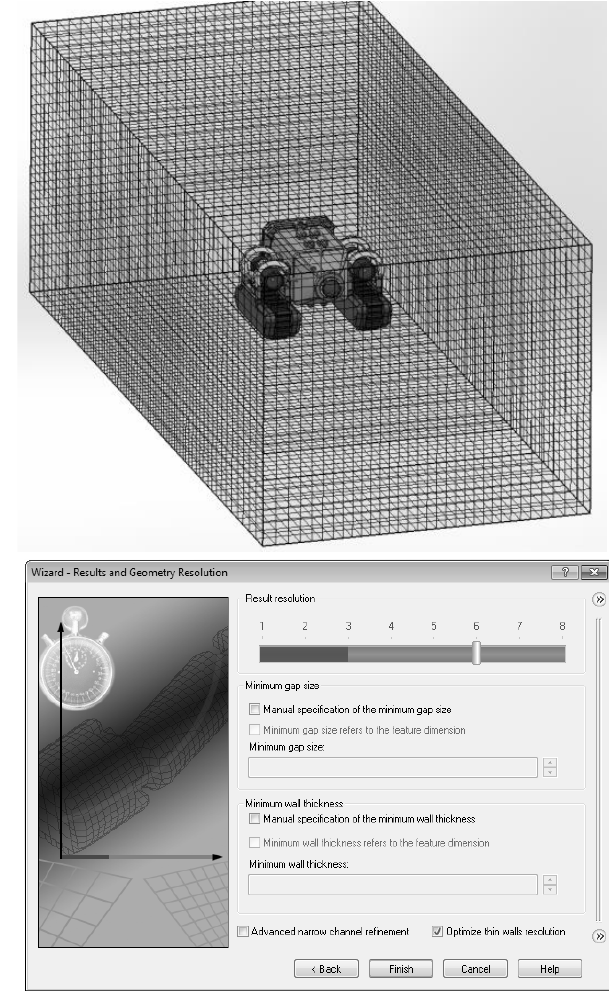
Figure 5: Defining the CFG grid Fig. 5. Defining the CFG grid density